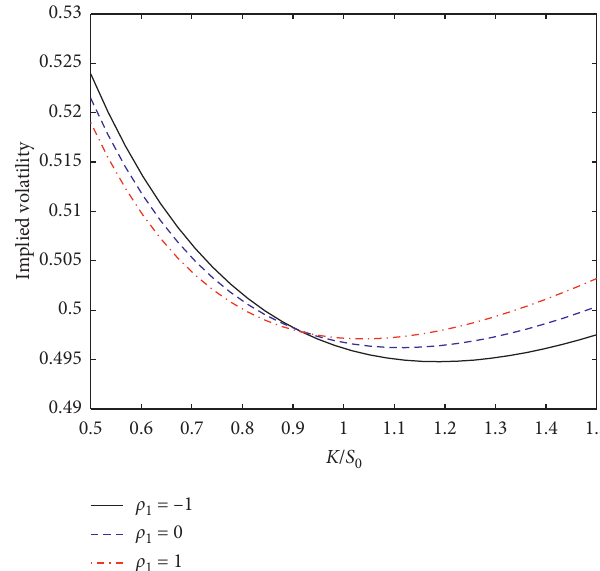
Figure 4: Implied volatility for different values of ρ . 2